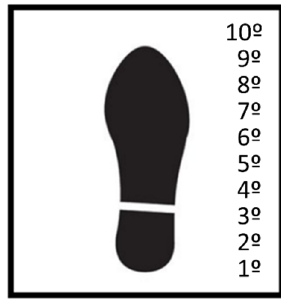
Figure 5. Location of transducers in a row on the platform.